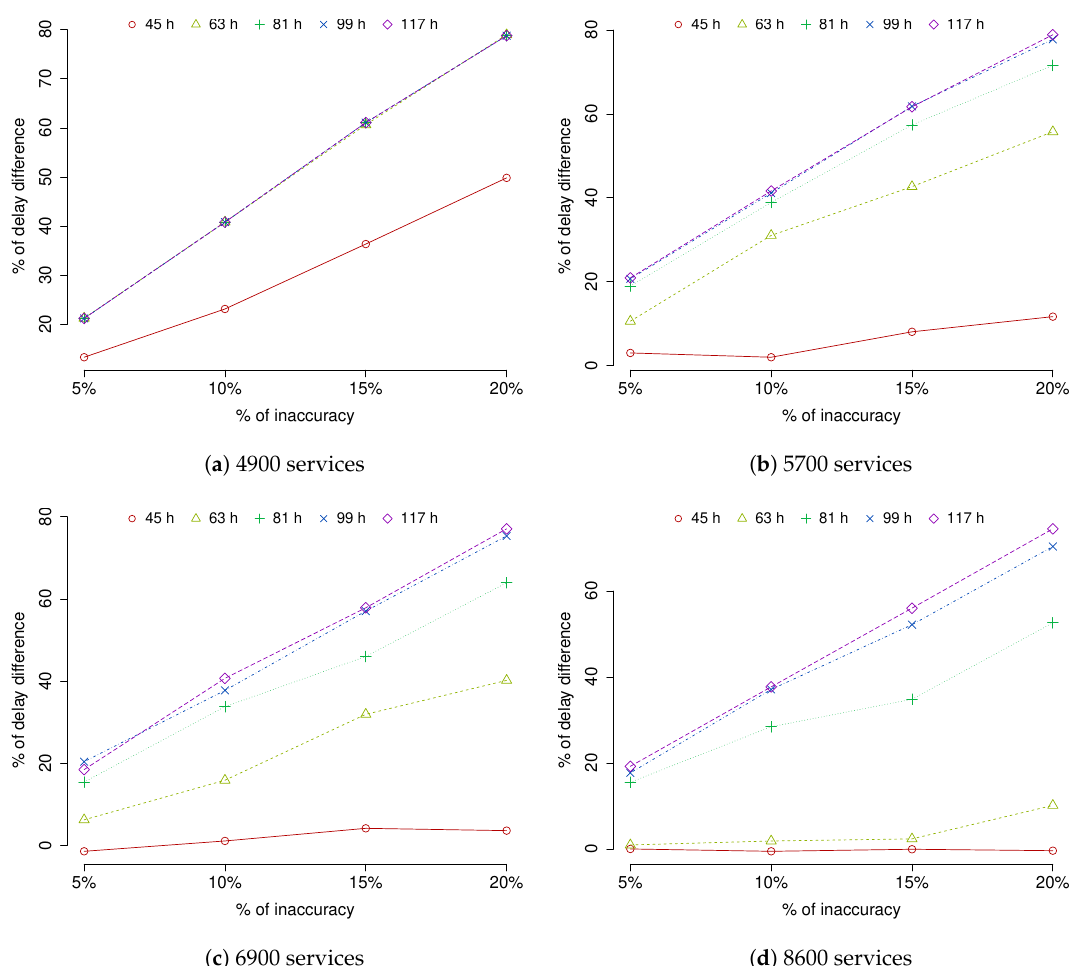
Figure 8. Percentage of delay degradation compared to several levels of prediction